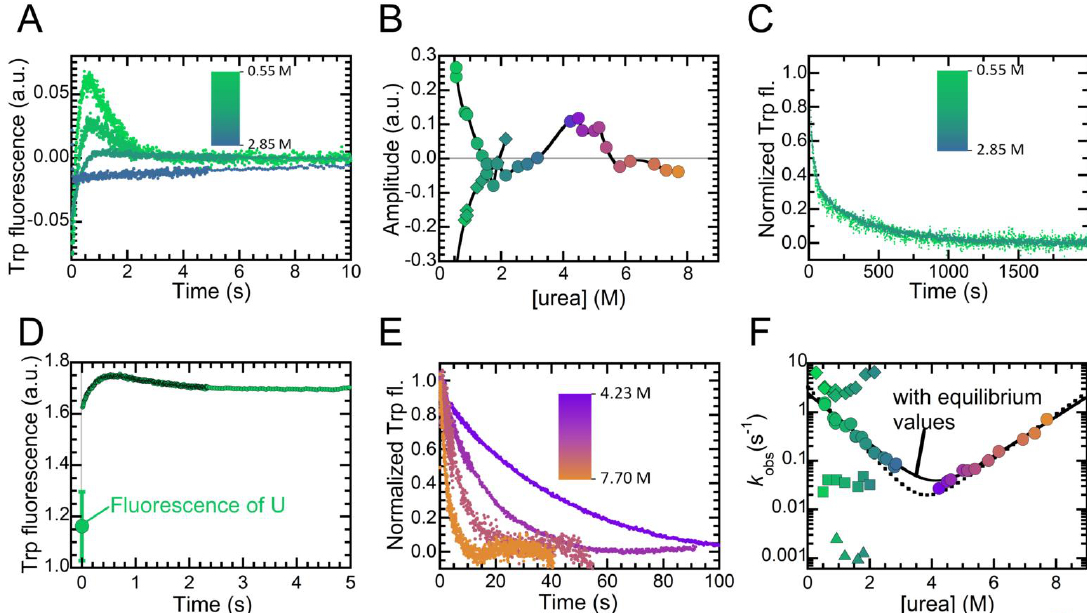
Figure 5. Folding kinetics of NTD. ( A ) Refolding traces monitored by tryptophan fluorescence at the urea concentrations indicated. ( B ) Amplitude of the first (diamonds) and second (circles) folding exponential phases, and of the unique unfolding phase (circles) as gauged by best fits of experimental kinetic traces to double exponential equations, plotted as a function of denaturant concentration. Color scale as in panel A and C . ( C ) Third and fourth refolding phase of NTD, monitored by tryptophan fluorescence. Color scale as in panel A . ( D ) Comparison between a refolding trace measured in 0.6 M urea and the fluorescence intensity of the unfolded state (U) under the same conditions, determined from a linear extrapolation of the signals emitted at high urea concentrations. ( E ) Unfolding traces monitored by tryptophan fluorescence recorded at the indicated urea concentrations. We normalized these traces to the fraction of folded protein. ( F ) Folding / unfolding rate constants of NTD plotted vs. urea concentration. Data are shown for the first (diamonds, associated with k 1 ), second (circles, associated with k 2 and k u ), third (squares, associated with k 3 ) and fourth (triangles, associated with k 4 ) observed phases. Color scale as in panels A and E . Dashed and continuous lines correspond to the best fits of the experimental data to Equations (3) and (4), respectively.